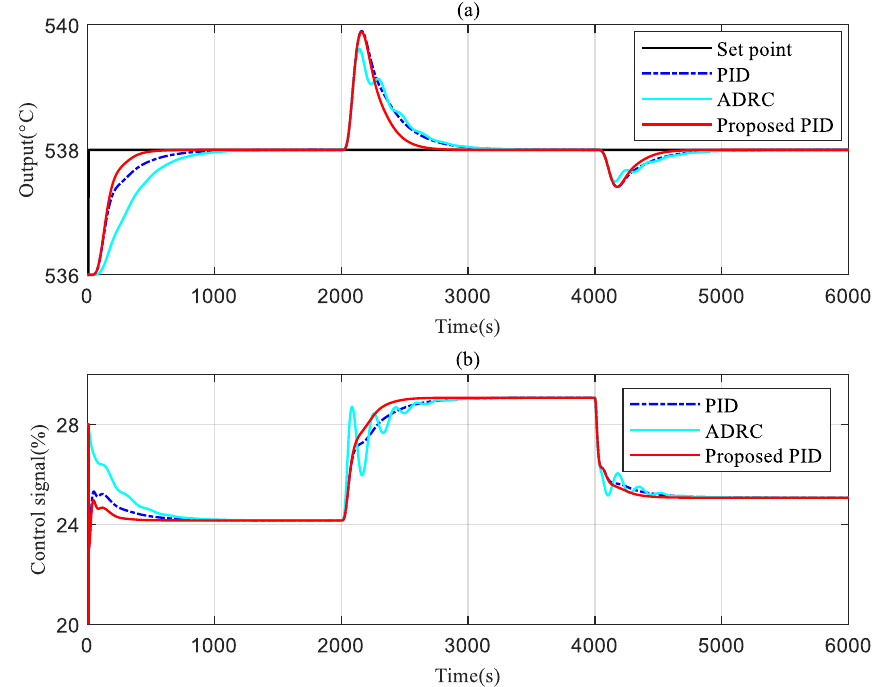
Figure 5. Control performance under an operating condition of 100% load ( a ): outputs, ( b ): control signals.